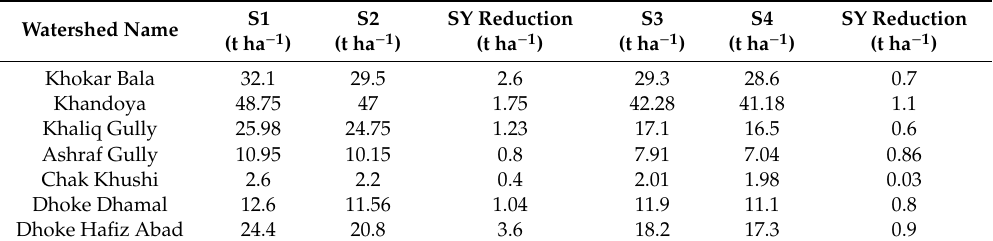
Table 4. E ff ect of di ff erent scenarios on sediment yield reduction (S represents land use scenario and SY is the sediment yield i.e., the amount of sediment received at the outlet of each watershed in a given period of